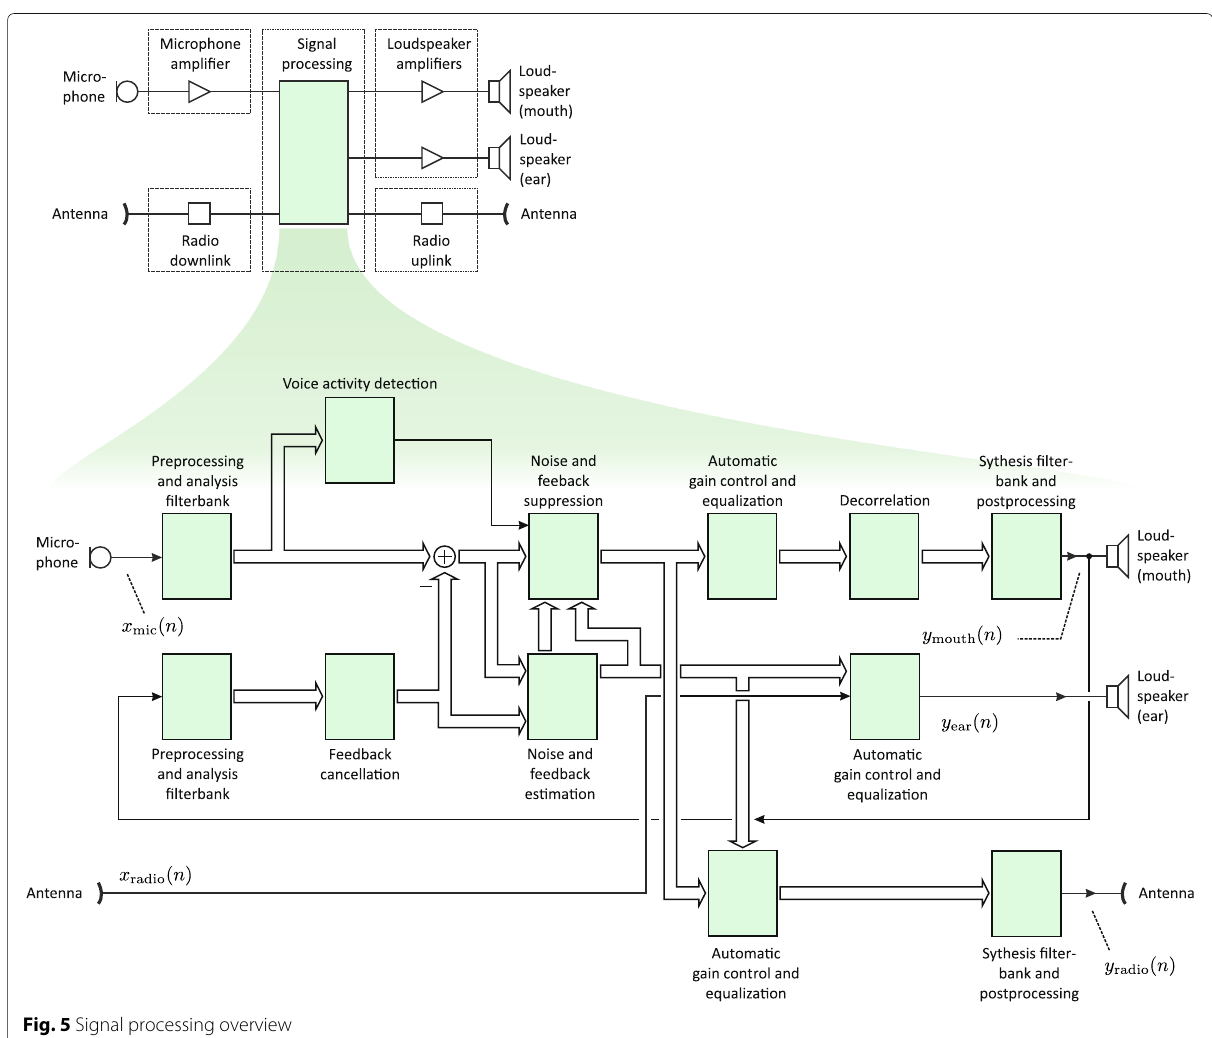
and a basic frameshift of R = 64. For the window, an appropriately scaled Hann window is used. Due to the conjugate complex symmetry in the spectral domain only N DFT / 2 + 1 = 129 subbands need to be processed. At a sample rate of f s = 16 kHz this results in an overall delay of the analysis/synthesis system (see Section 3.6